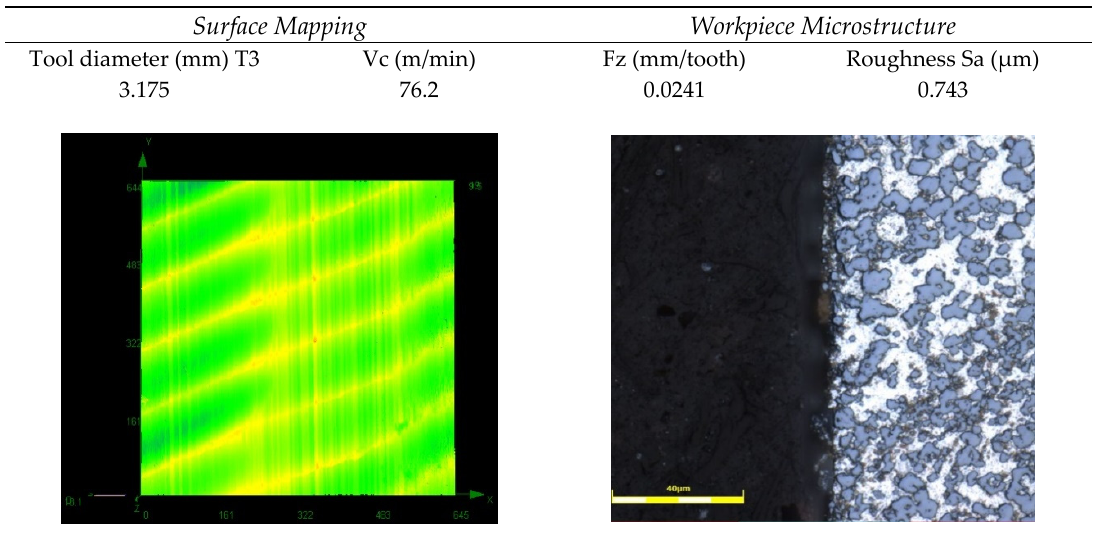
Figure 15. Evolution of the vibration as a function of the variation of ( a ) cutting speed and ( b ) feed rate for the Al6061-T6 alloy.